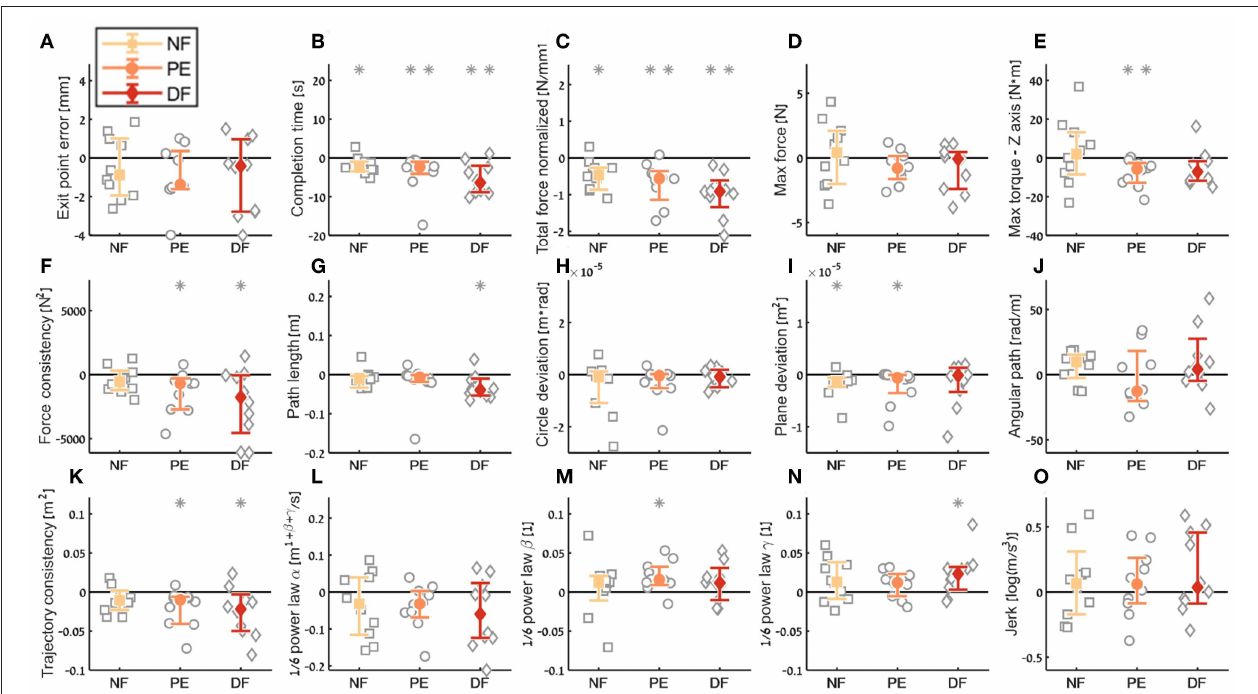
FIGURE 10 | Summary of the dVRK teleoperation learning during the insertion subtask. For each metric (A–O) , median of difference between late teleoperation stage to early teleoperation stage is presented. Each gray marker represent individual subject. Error bars shows median of each group difference (NF, PE, and DF) and 95% bootstrap confidence interval. Gray asterisks represent the result of a Wilcoxon sign rank test for difference from